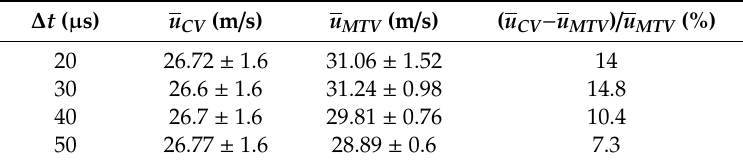
Table 9. Average velocities u CV and u MTV with estimated uncertainties, and relative deviation between u CV and u MTV calculated for the image data of Figure 18. The uncertainty range has a confidence level of